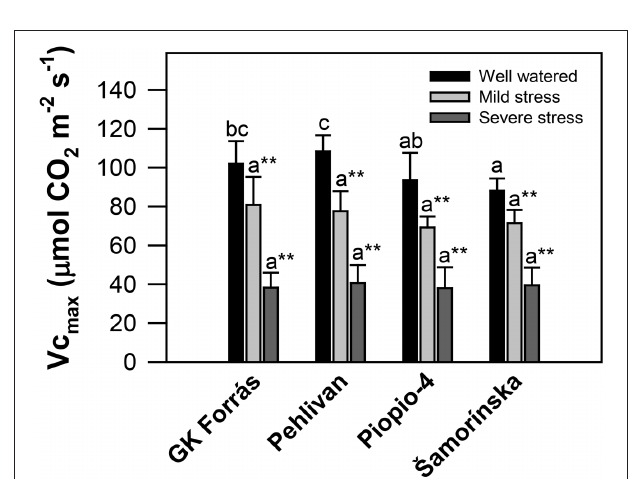
FIGURE 4 | The maximum rate of carboxylation of Rubisco (Vc max ; µ mol CO 2 m − 2 s − 1 ) calculated from the gas-exchange data measured in the leaves of four wheat genotypes at different levels of drought stress. Vertical bars are the means of 9–20 individual measurements per treatment ± S.E. Different letters indicate significant differences among genotypes ( p < 0.05) based on Duncan’s post hoc test at one stress level; **Indicates significant differences among stress treatments ( p < 0.01) based on the HSD test in one